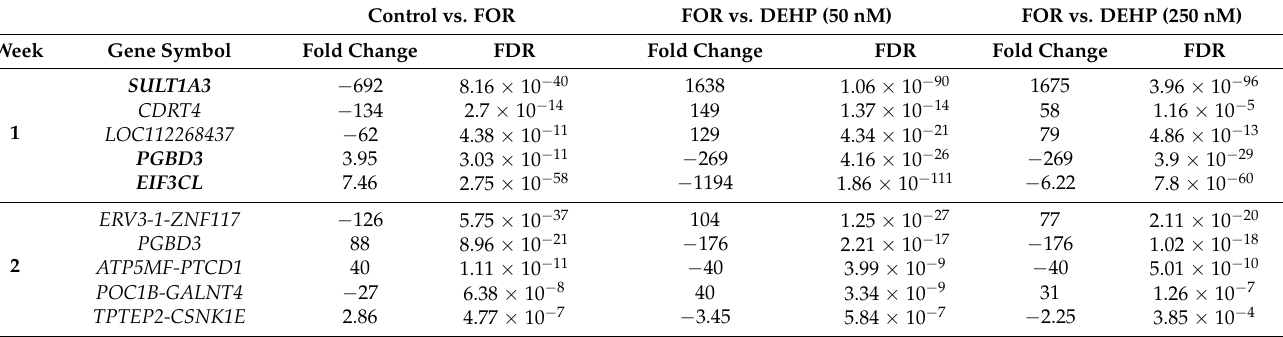
Table 3. The top five DEGs after 1, 2, 3, and 4 weeks of the repeated DEHP50 and DEHP250 exposure under the FOR-stimulated conditions. Control vs.